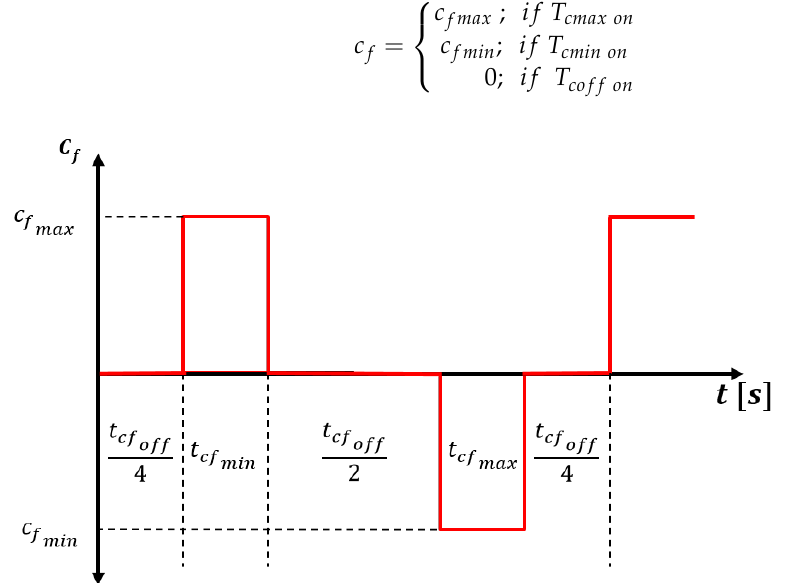
Figure 4. 𝑐 𝑓 behavior during the AFDPCF operation. Figure 4. c f behavior during the AFDPCF